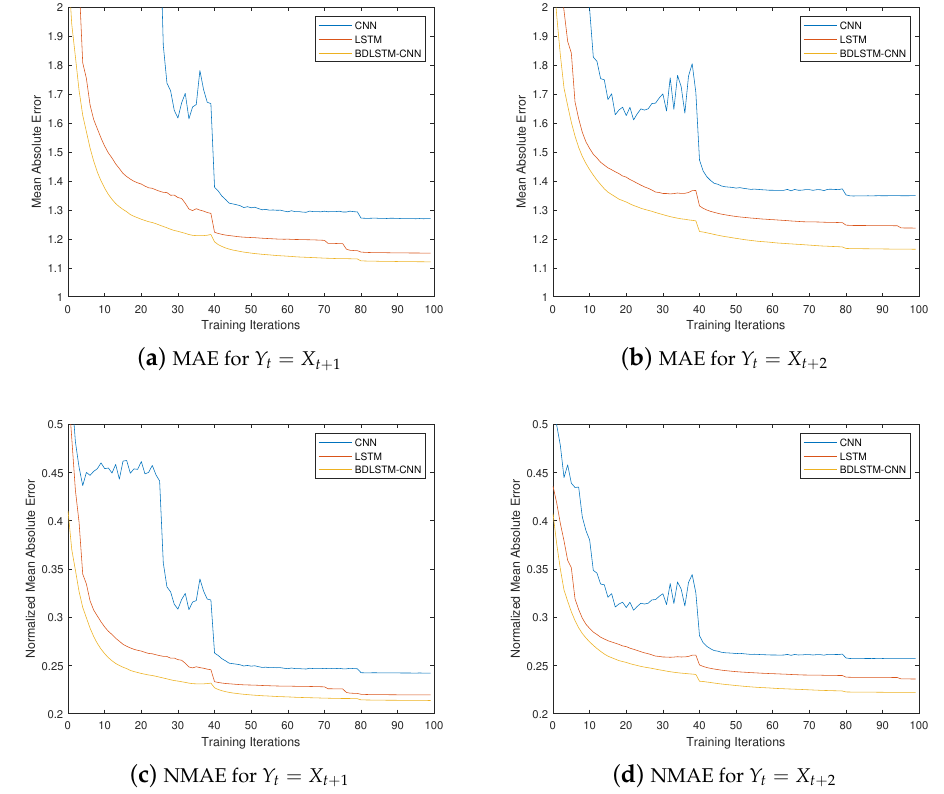
Figure 6. Performance Regarding MAE and